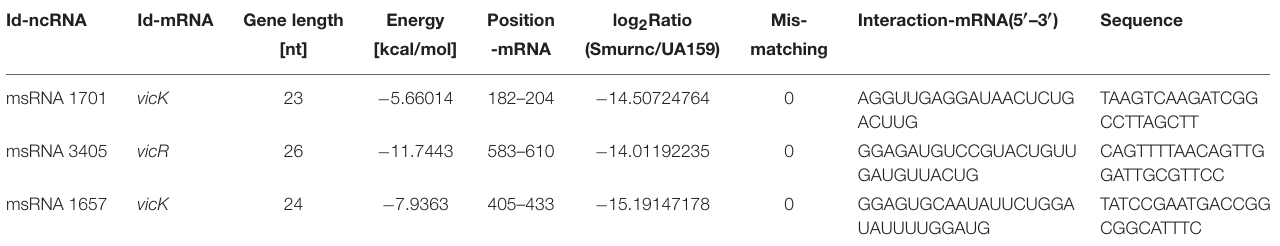
TABLE 2 | The detailed information of three validated msRNAs in S.